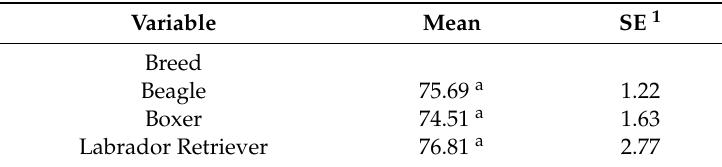
Table 6. Adjusted mean comparison between di ff erent breeds for food preference (%) of kennel